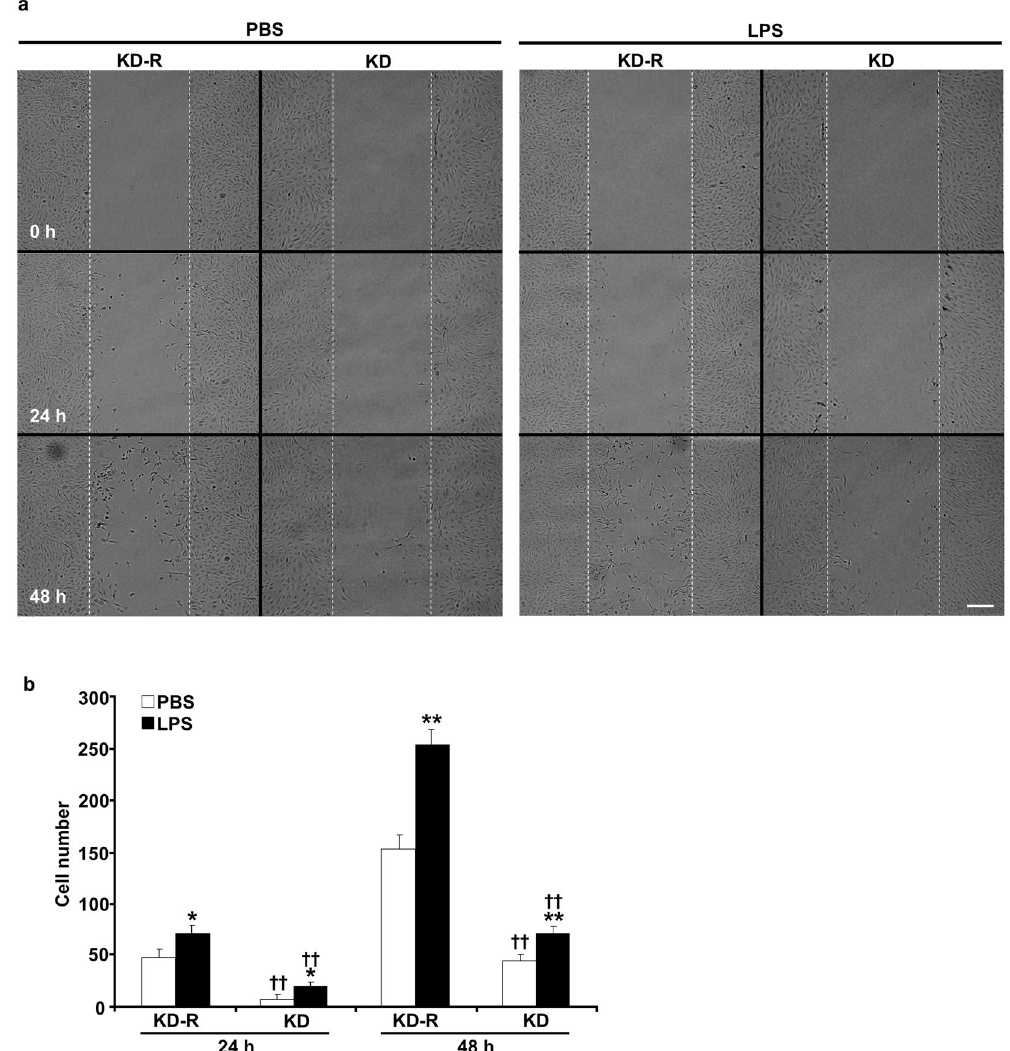
Figure 7. Decreased LPS-induced cell migration in Shp2 deficient podocytes. ( a ) Differentiated E11 podocytes with Shp2 knockdown (KD) and rescue (KD-R) were cultured with PBS and LPS for 48 hours after wound induction. Images were acquired before treatment (0 h) and at 24 and 48 h post wound. Scale bar: 200 µ m. Cell numbers in the wound track were counted and presented in the bar chart ( b ) as means + SEM from four independent experiments. * p < 0.05 and ** p < 0.01 indicate a significant difference between PBS and LPS treatments; †† p < 0.01 indicates a significant difference between KD-R and KD